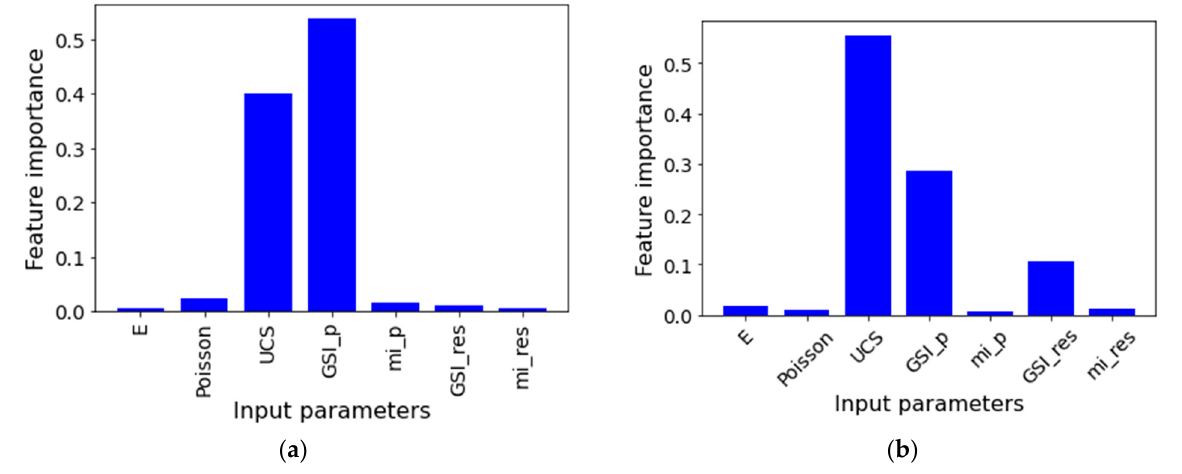
Figure 13. Feature importance results for ( a ) the vertical excavation problem and ( b ) the inclined slope stability